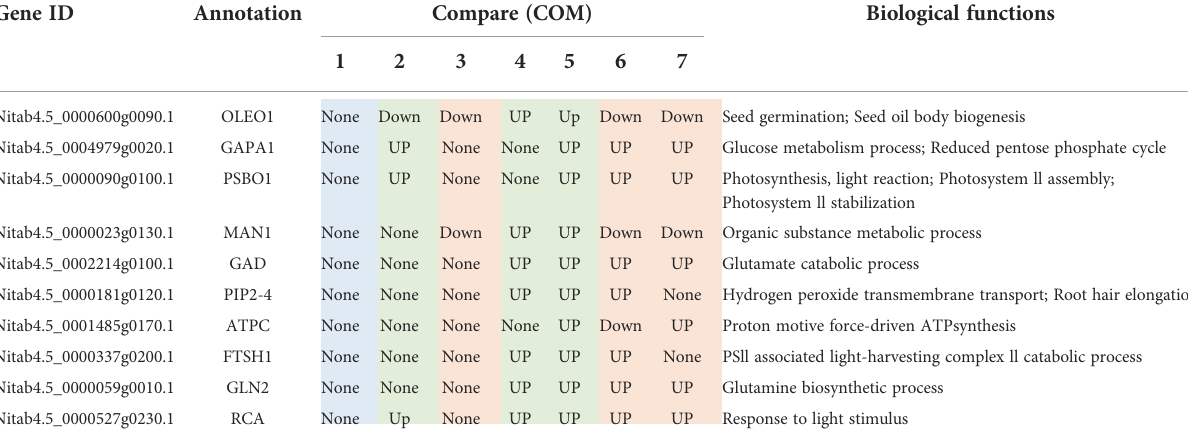
TABLE 2 Expression patterns of hub genes (proteins) during germination and post-germination development in light and dark. Gene ID